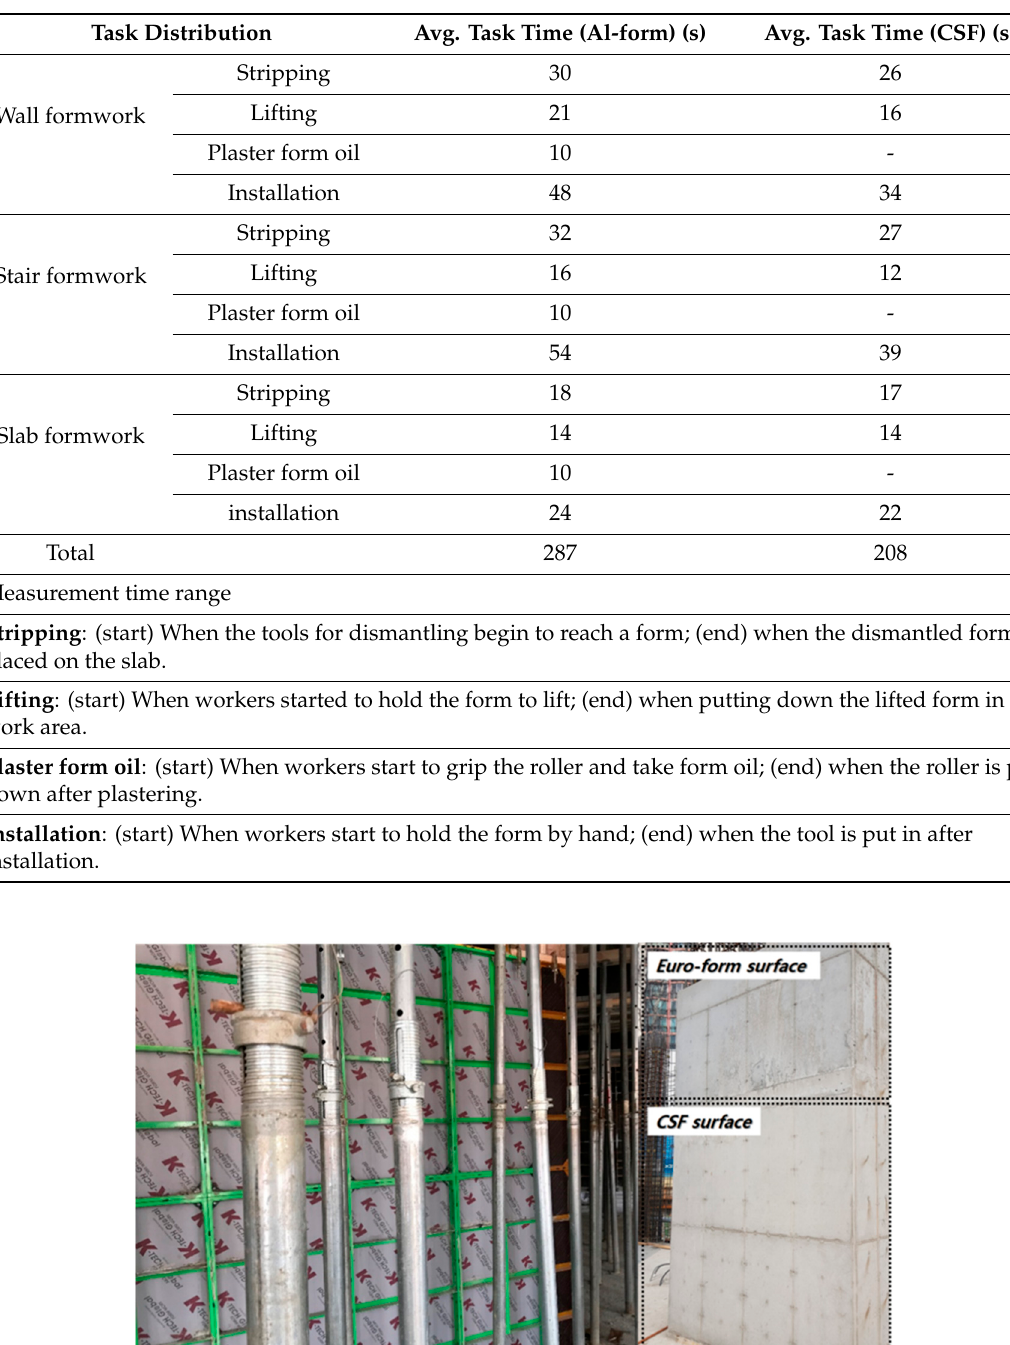
Table 9. Performance comparison between CSF and Al-form.